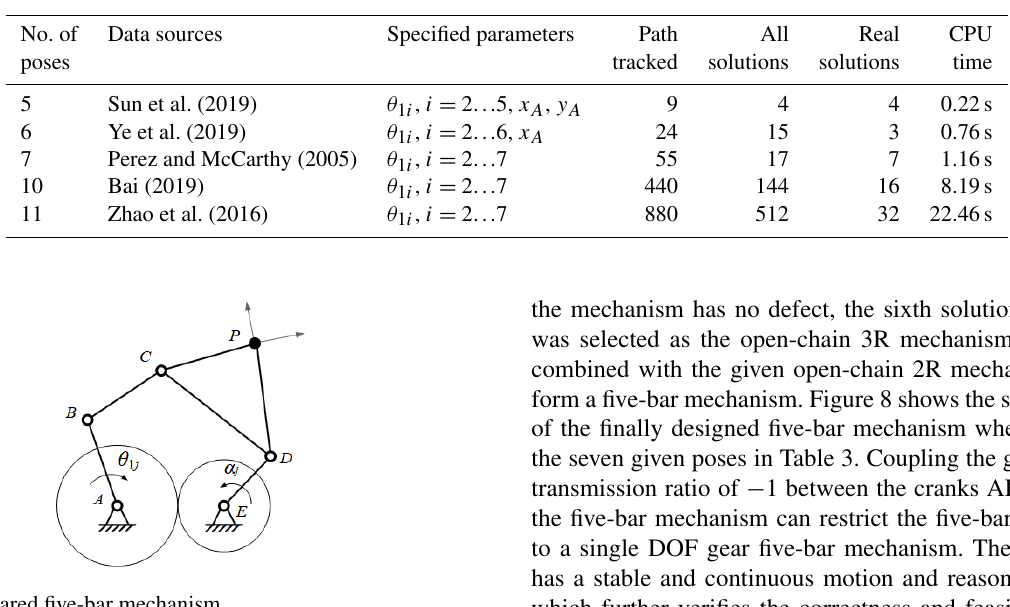
Table 2. The numerical example results.